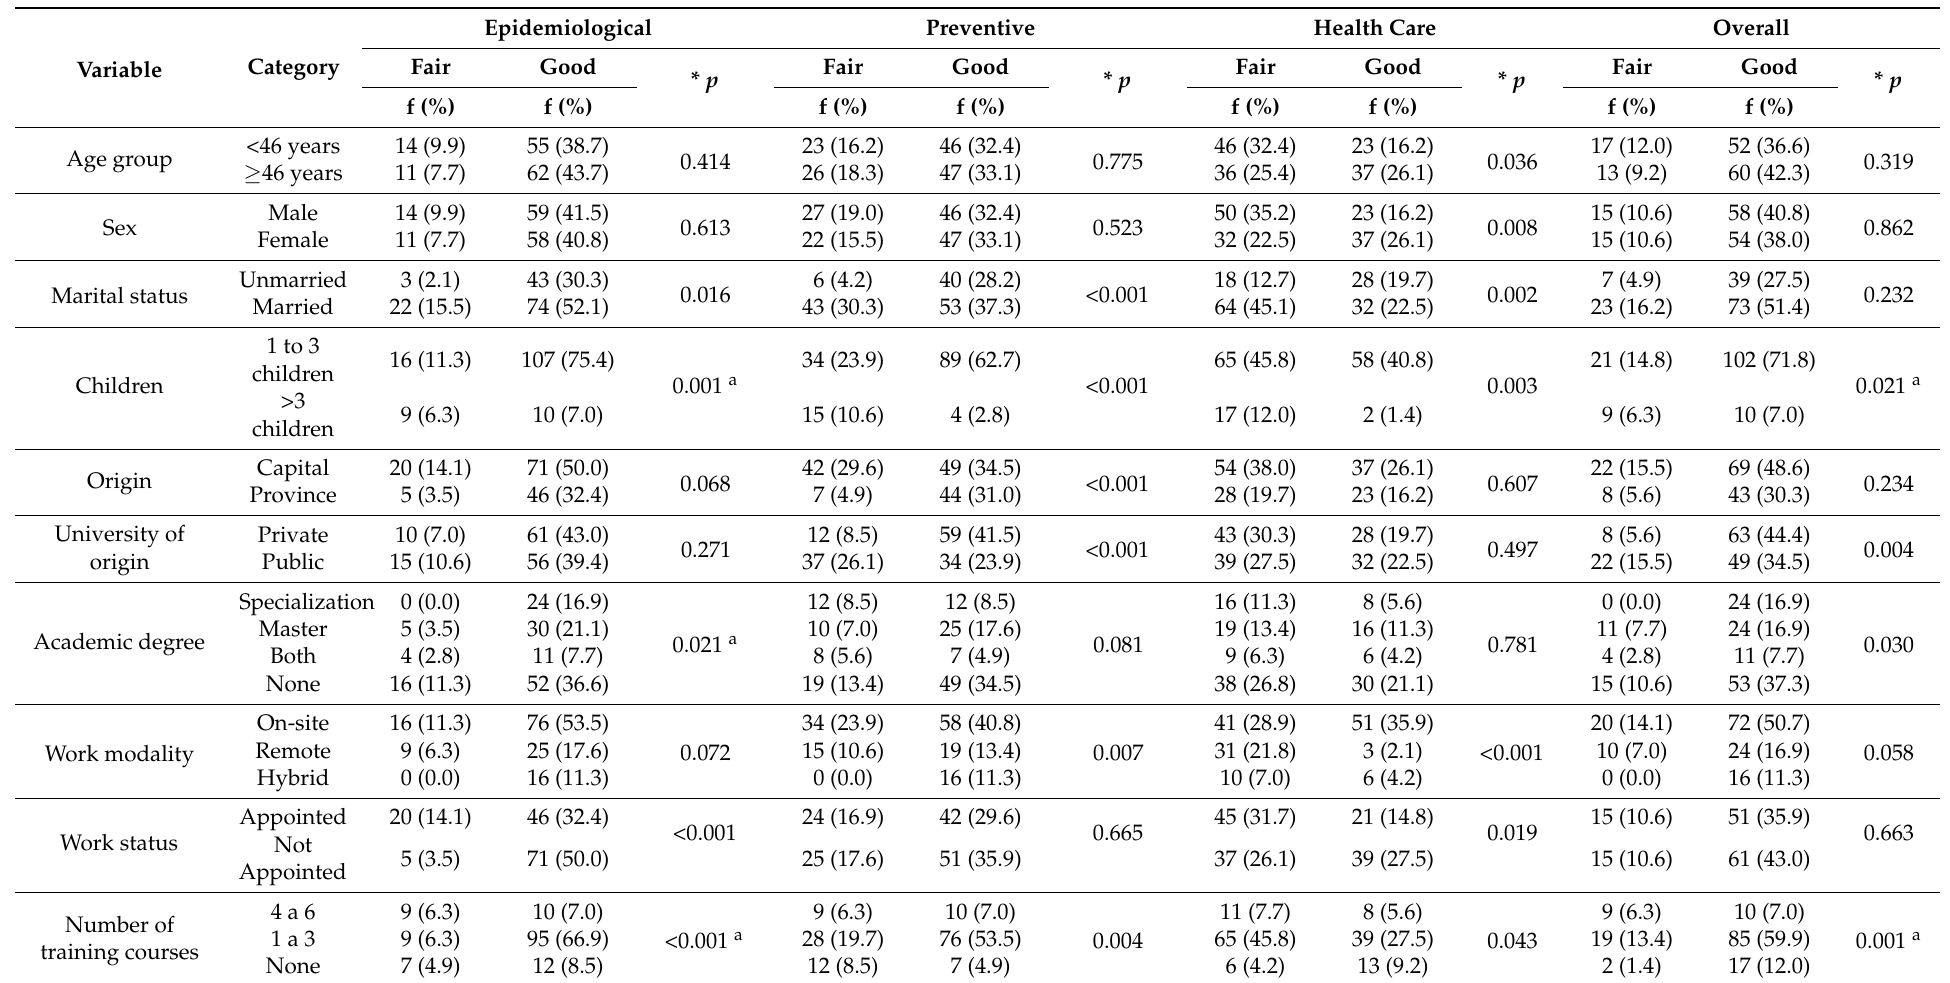
Table 3. Sociodemographic factors associated with epidemiological, preventive and health care knowledge of DIRIS Lima Norte dentists about